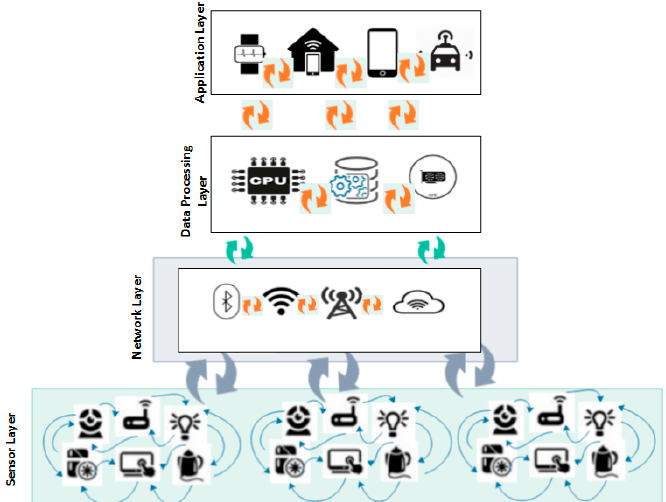
Figure 1. Layered-based system model with different motes communicating redundantly in IoT.